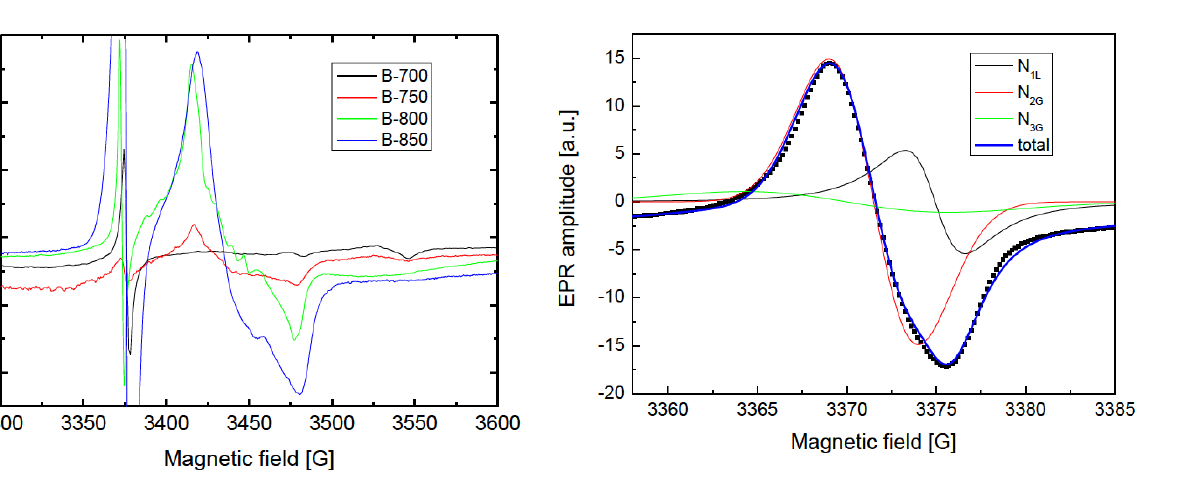
anatase content is low. This line is broader because of the surface heterogeneity. Such a line could be formed by re- ductive annealing [66].